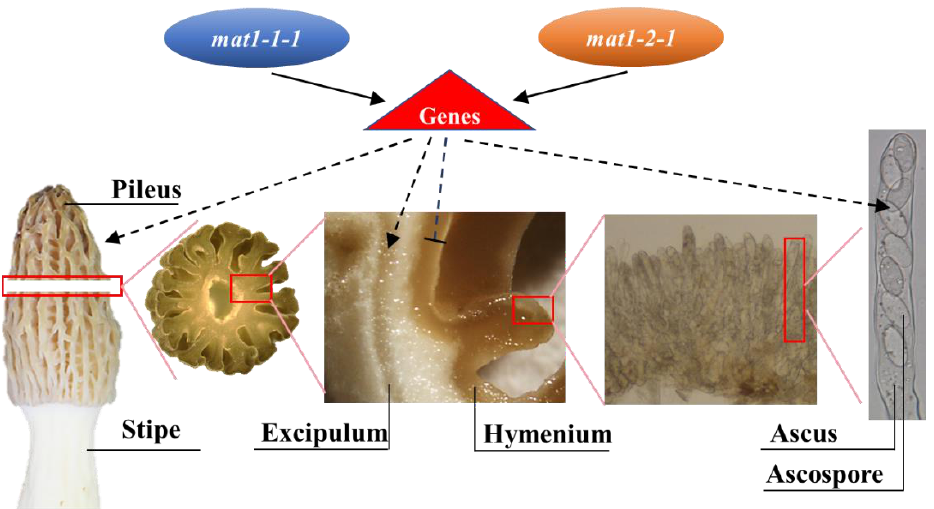
Figure 8. Coregulation model of mating-type genes on fruiting body development in Morchella. A group of genes play different roles in the hymenium, excipulum, and ascus development. Mating- type genes, such as mat1-1-1 or mat1-2-1, can regulate these genes. The expression level of each mating-type gene showed an important role in the orderly development of the fruiting body. Dotted arrows represent the predictive impact of genes, the triangle represents promotion, and T represents inhibition. Solid arrows represent the reported relationship in other papers or examined in this paper. The red box indicates that the area was